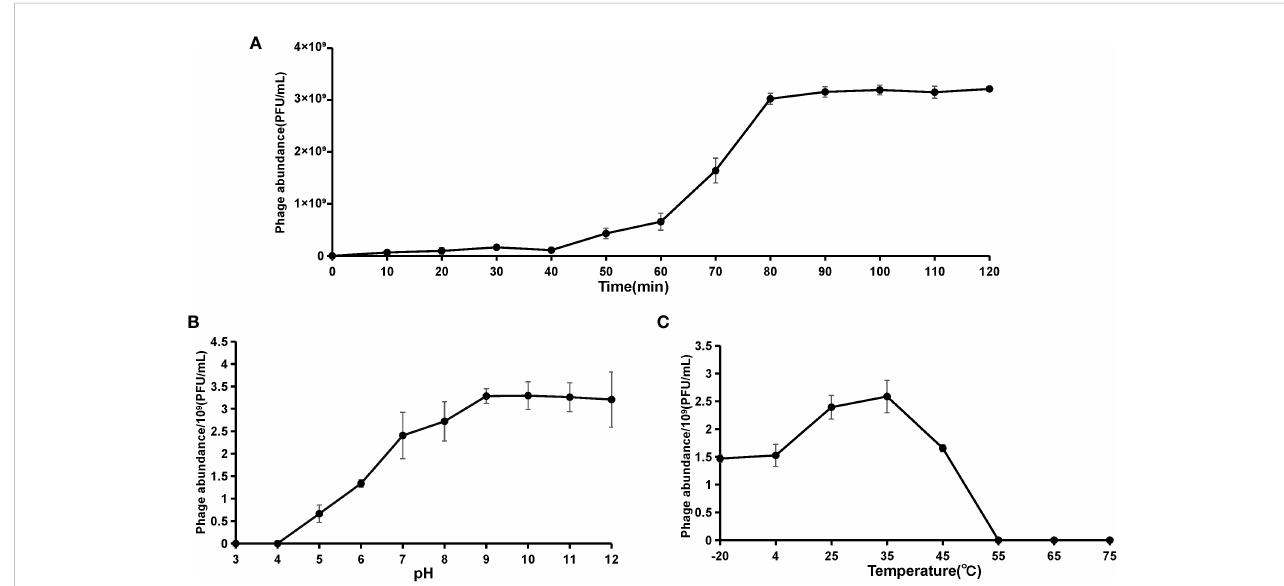
FIGURE 2 The curve of one-step growth (A) , pH stability (B) , and thermal stability (C) of Vibrio phage vB_VhaP_PG11. These experiments have been repeated three times, and the data are shown as mean ±